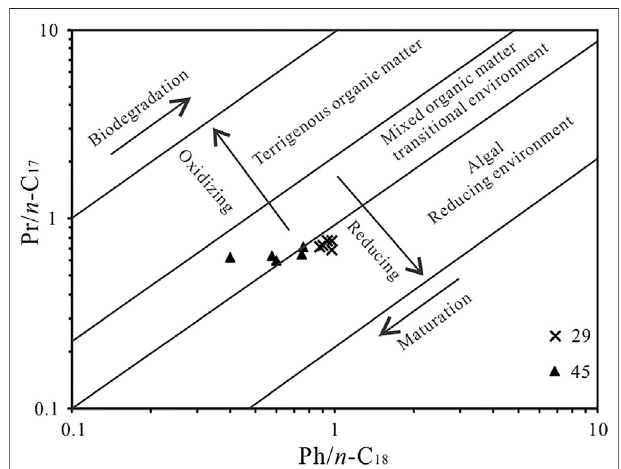
FIGURE5| Crossplotofphytaneton-C 18 alkane(Ph/ n -C 18 )vs.pristane ton-C 17 alkane(Pr/ n -C 17 )forcore 29andcore 45(modi fi edafter Connan and Cassou,